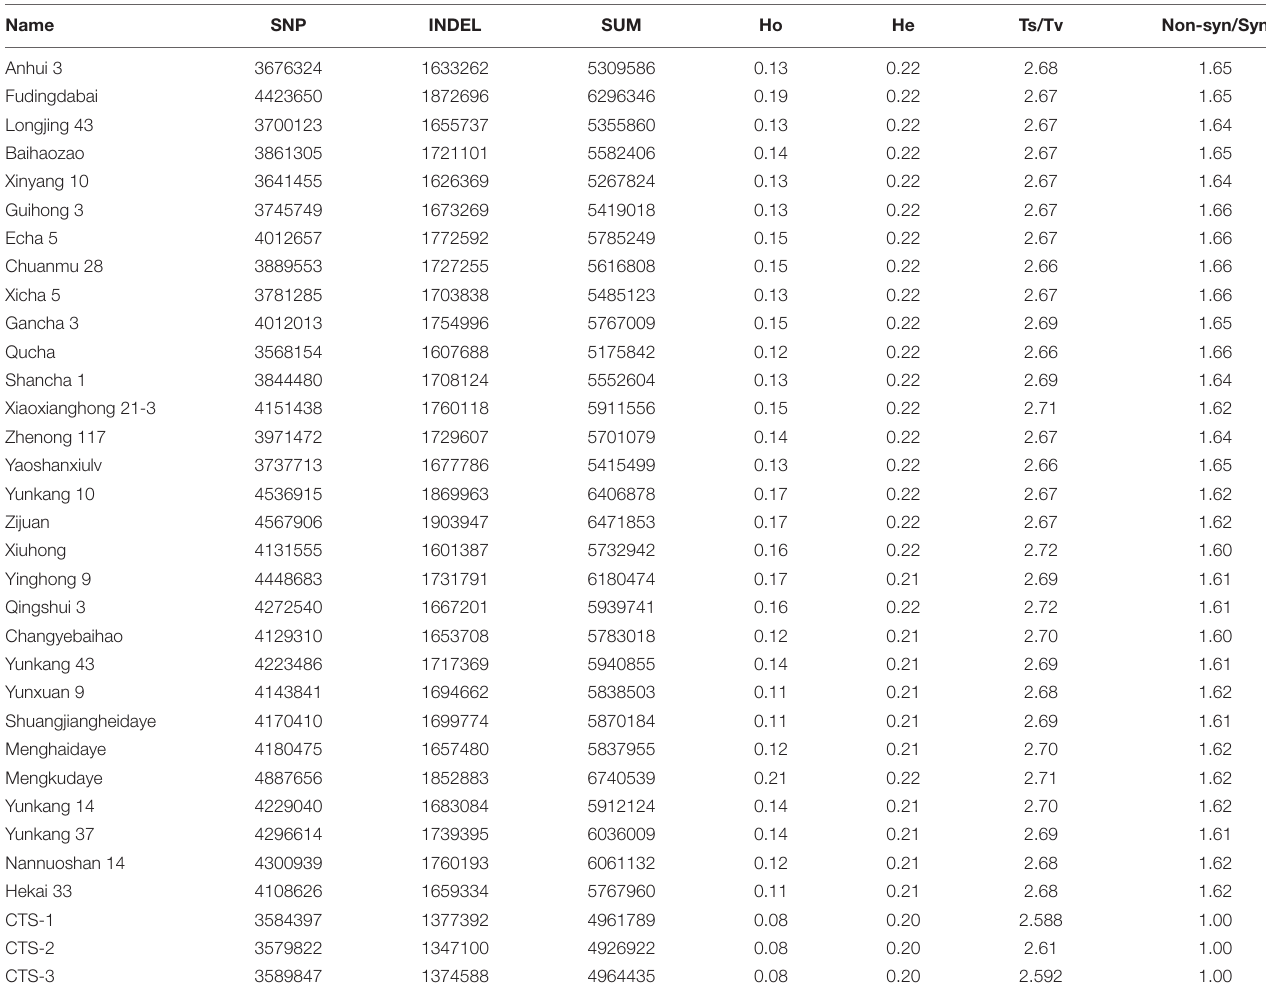
TABLE 1 | Summary of variants from all tea